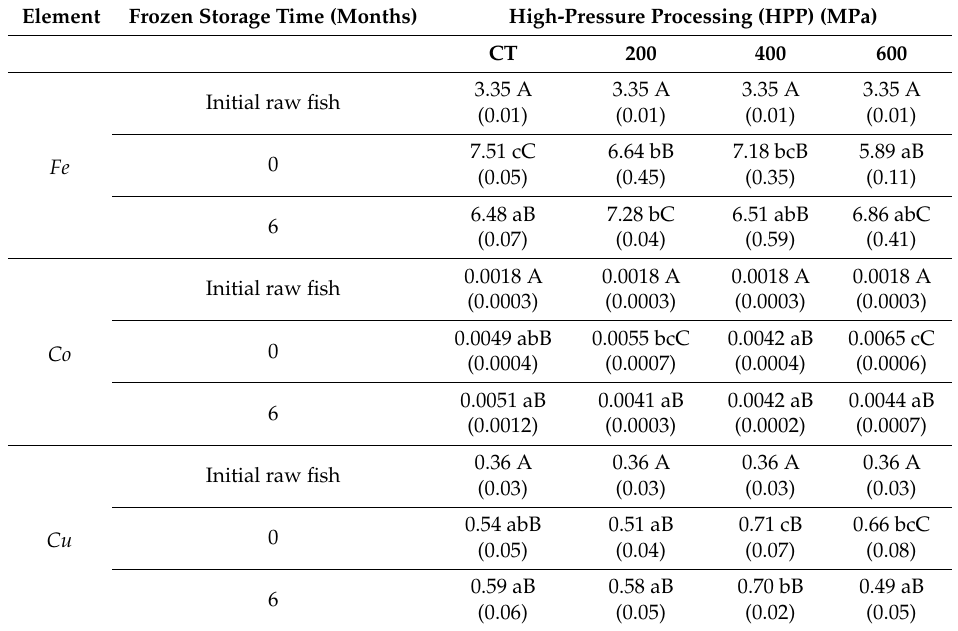
Table 3. Determination (mg · kg − 1 dry muscle) of di ff erent transition metal elements ( Fe , Co , and Cu